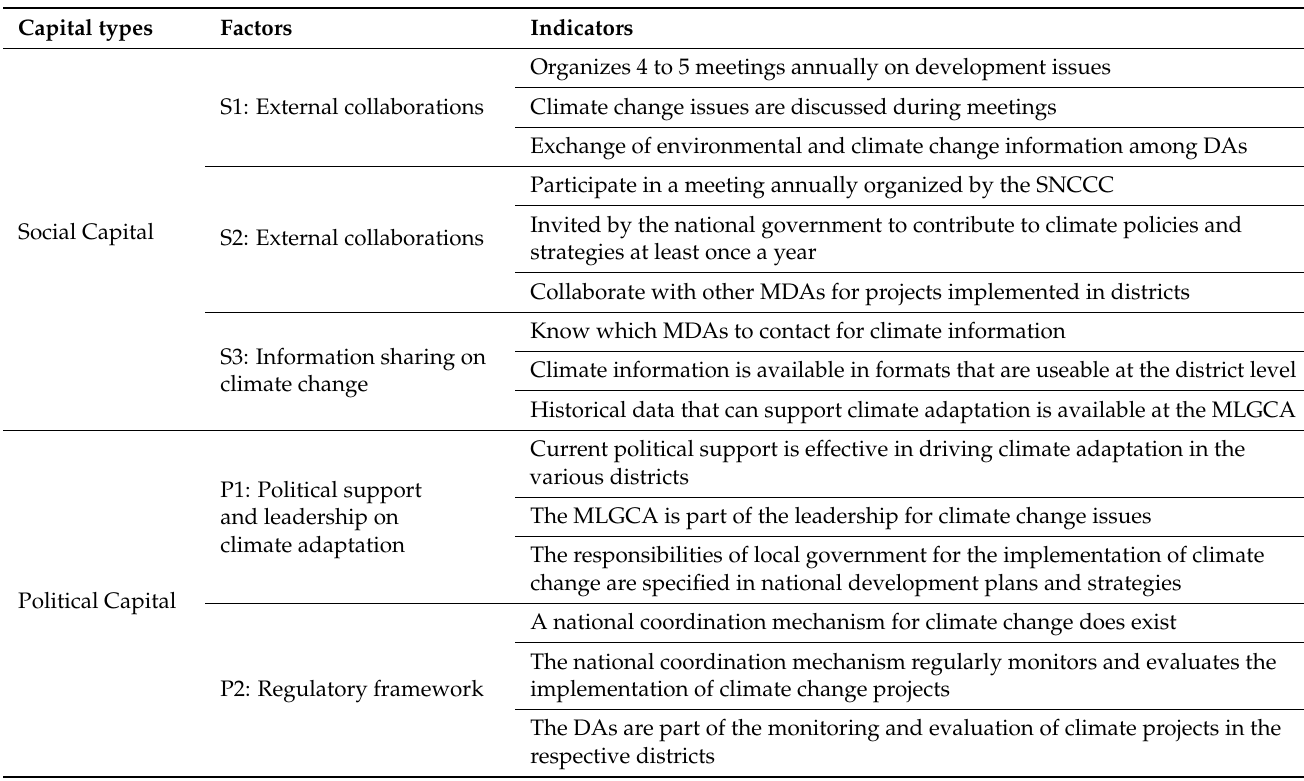
Table A1. Indicators used to assess the performance of factors and types of